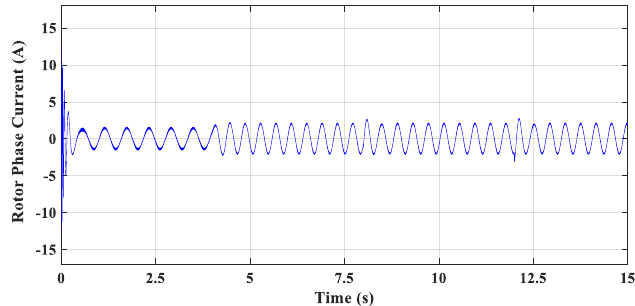
Figure 18. Rotor phase-current response under parameter changes (150% uncertainty).